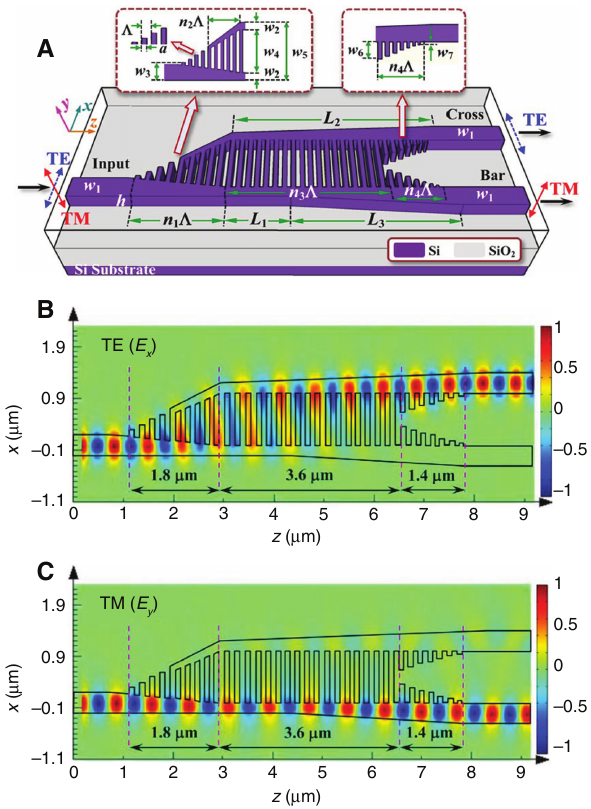
Figure 4: Theoretical study of an SWG-assisted